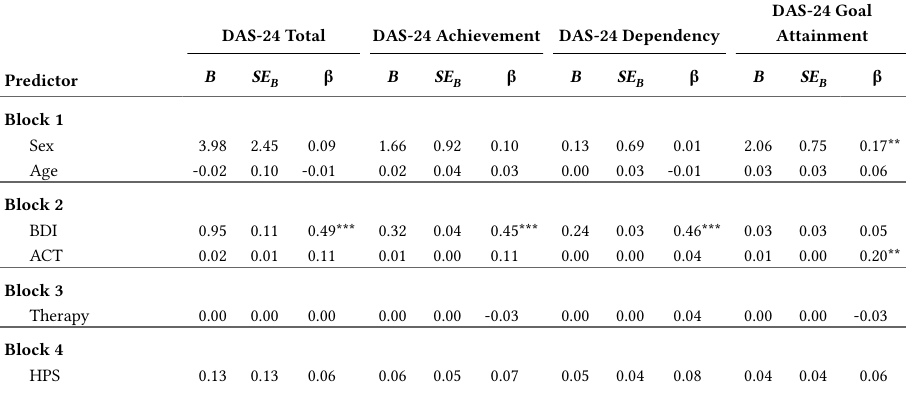
DAS-24 Total DAS-24 Achievement DAS-24 Dependency